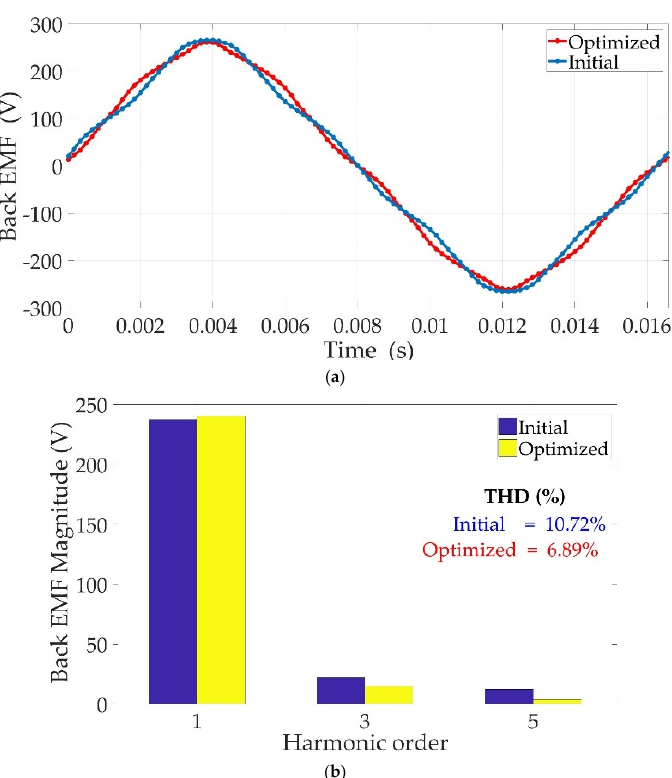
Figure 24. Comparison of back-EMFs. ( a ) Back-EMF vs. time. ( b ) First harmonic magnitudes. The cogging torque with respect to the rotor position and rated torque vs. time are shown in Figures 25 and 26, respectively. It can be seen that the initial PMVM peak-to- peak cogging torque is equal to 98 N.m, while the value of the optimized one is 42 N.m, and thus, reduced by 57%. When operating under rated motor mode conditions, the torque ripple decreases significantly from 14.08% to 5% between the optimized and initial prototypes. At the same time, the average torque increases from 1055 Nm to 1072 Nm for the optimal machine. The optimized prototype thus meets the requirement of the appli- cation with a torque ripple ratio below 5% and a power factor of interesting value.